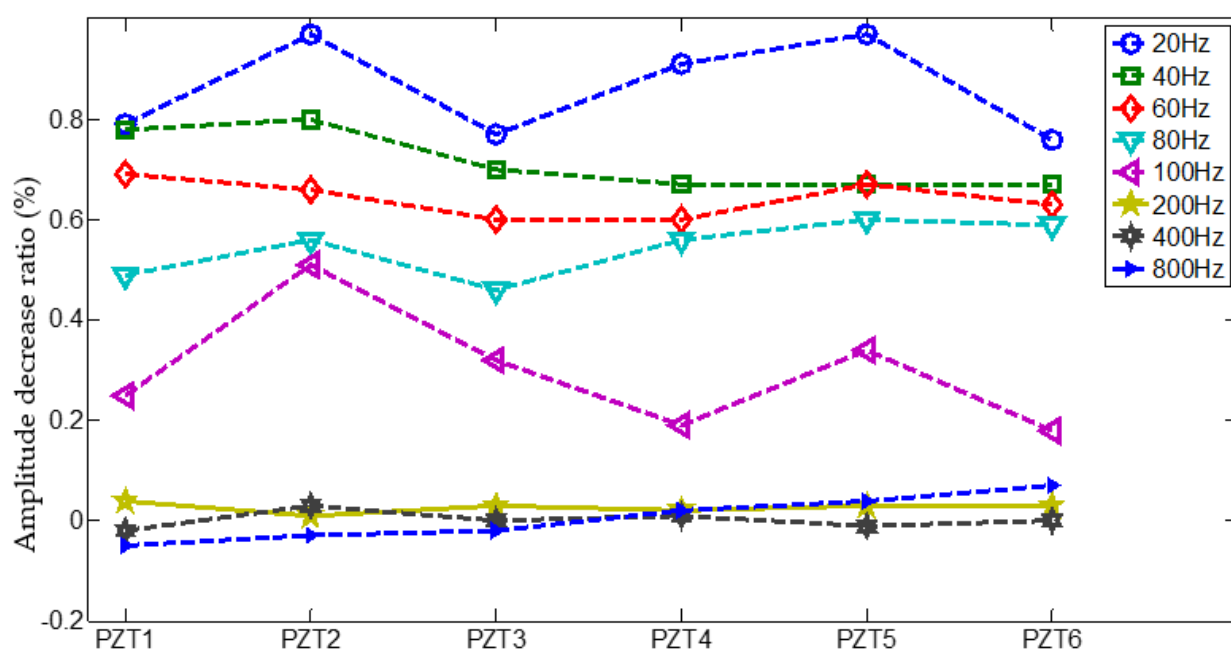
Figure 8. Extracted amplitude decrease ratio comparing with the signal in static condition. A comparison of PZT 1 sensor signals with different loading conditions is given in Figure 10. It can be observed from figures that their shape does not change significantly when applied load changes. The amplitudes of each PZT signal increase and the TOF de- crease as the load increases. The amplitudes and TOF magnitude of each PZT of sensor array change are different due to the different propagation path. Here, we defined the gain-phase errors contrast caused by loading and demonstrated in Figure 11.